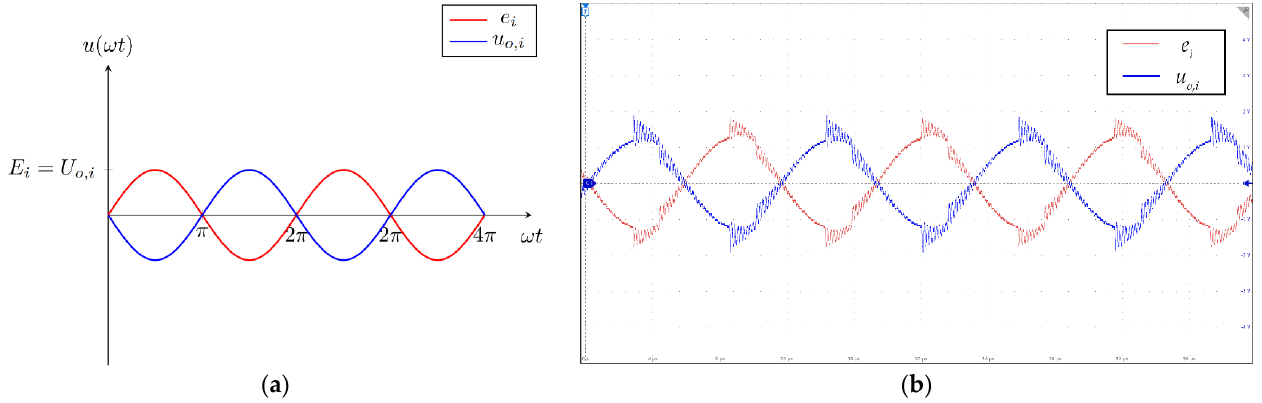
Figure 6. Input and output voltages of the first stage of the measurement circuit: ( a ) theoretical waveforms; ( b ) waveforms measured on the measurement system.